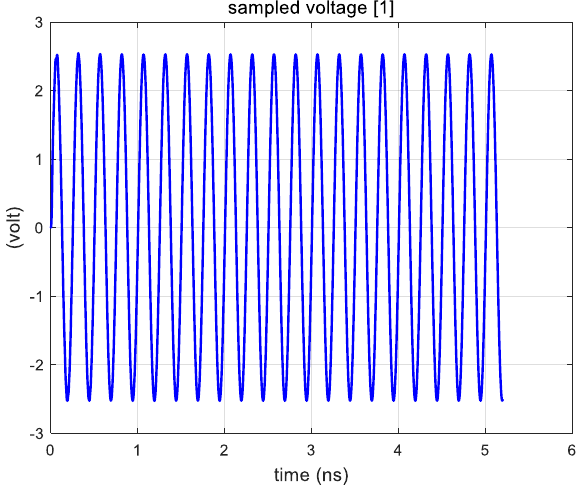
Figure 13. Results for the improved equivalent circuit method.